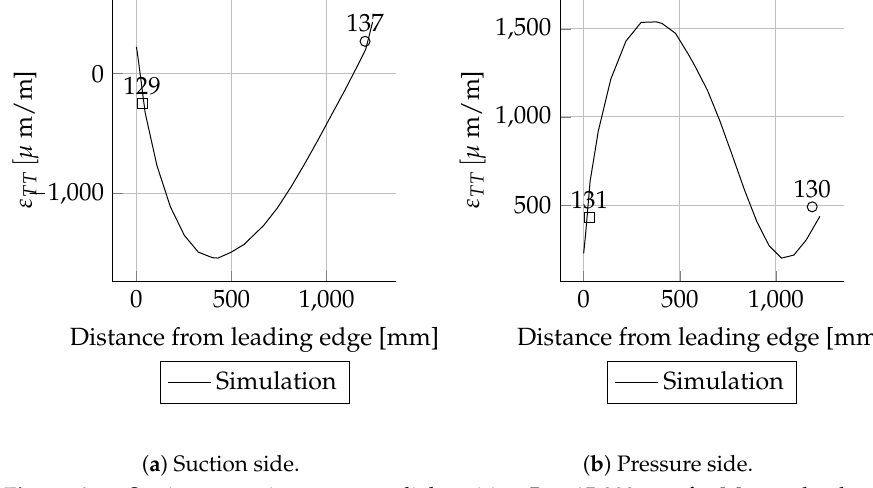
Figure A37. Strain comparison ε LL at radial position R = 15,000 mm for Mymax load case.